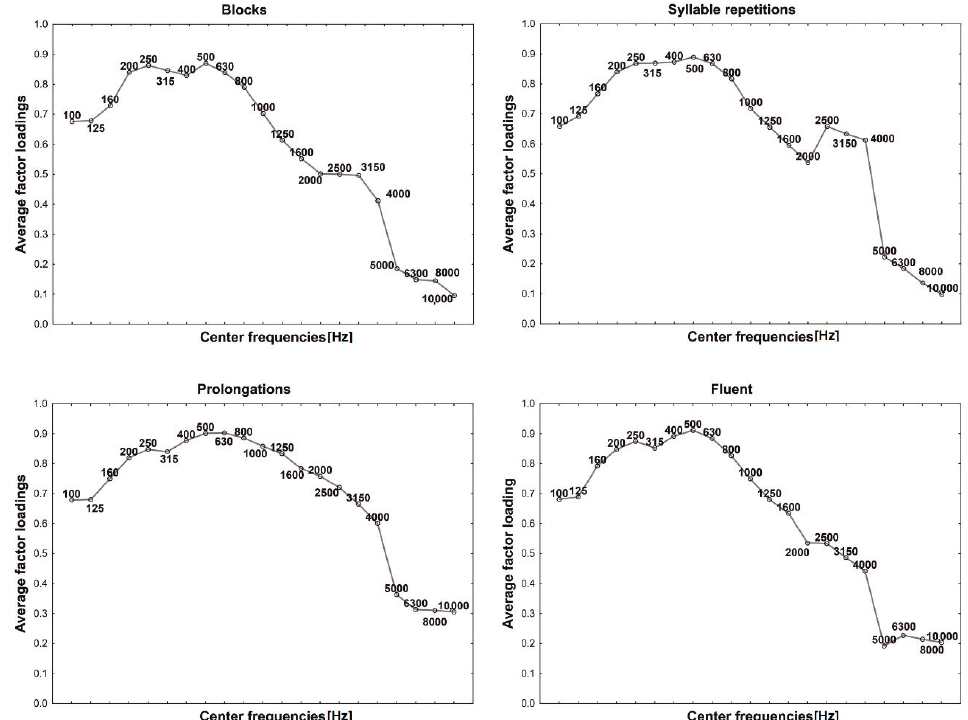
Figure 3. First component (G 1 ) factor loadings.